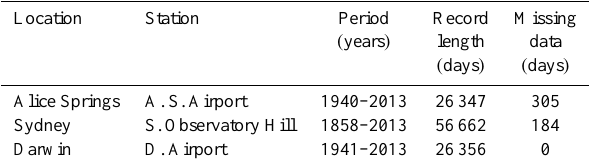
Table 1. Summary of the data set